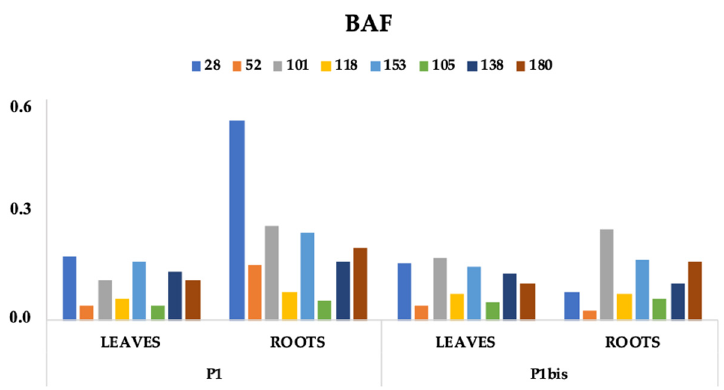
Figure 4. Bioaccumulation factor (BAF, average values) of each single PCB congener calculated for leaves and roots 900 days after poplar planting in the P1 and P1bis plots.